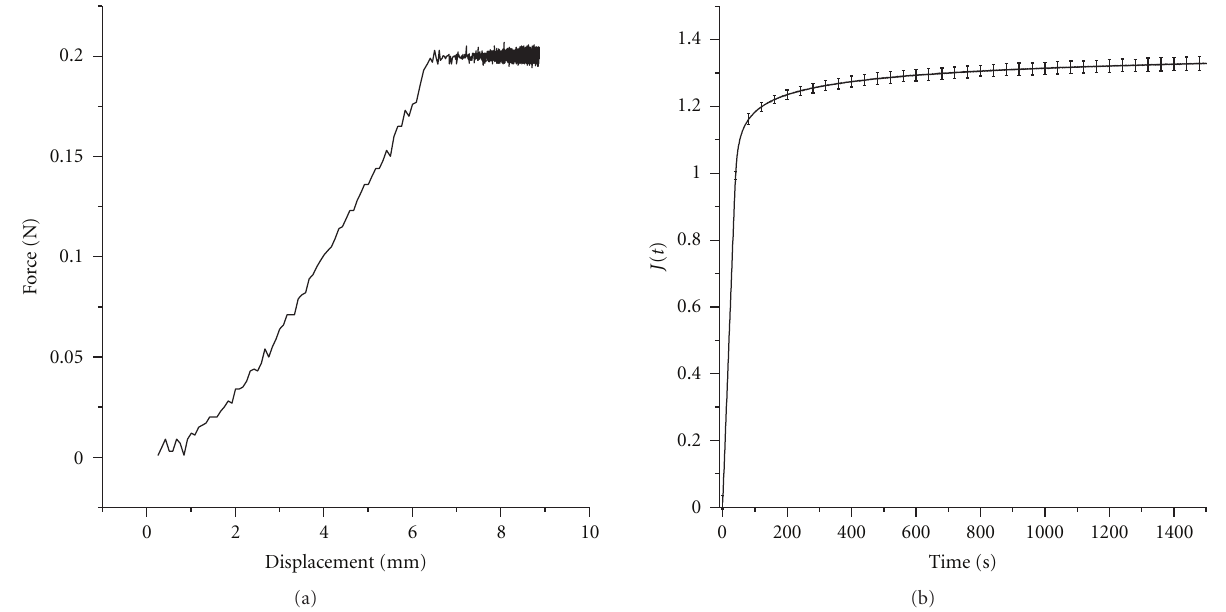
Figure 2: Mean creep for 1.67%/s loading rate for 5 EOM specimens. (a) Force versus displacement. After initial ramp loading achieved at around 6mm deformation, the force was held constant at 0.2N. (b) Reduced creep coe ffi cients over 1,500 seconds. Maximum creep coe ffi cient SD was 0.023.